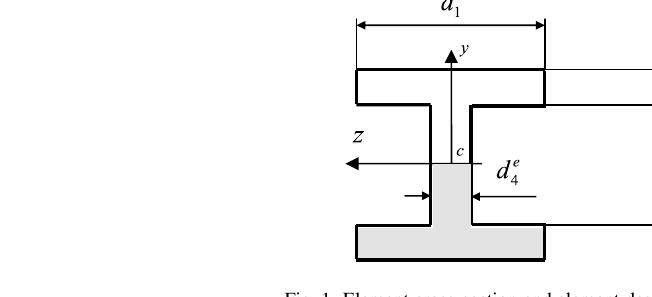
Fig. 1. Element cross-section and element design